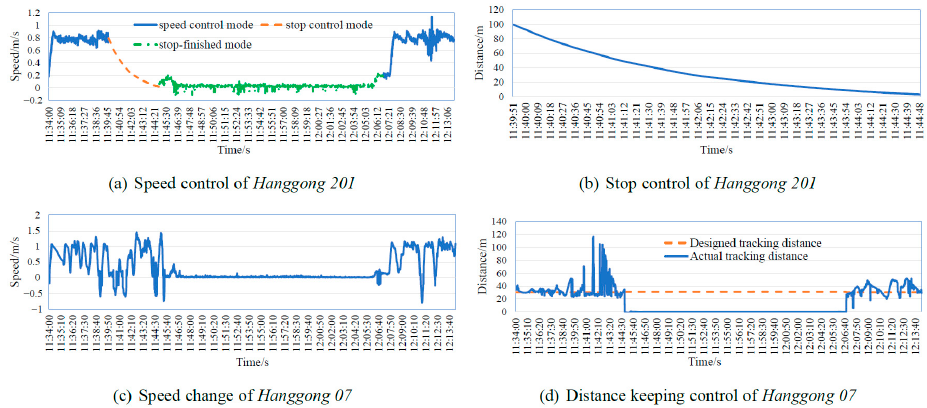
Figure 11. Results of formation control during passing through the lock.